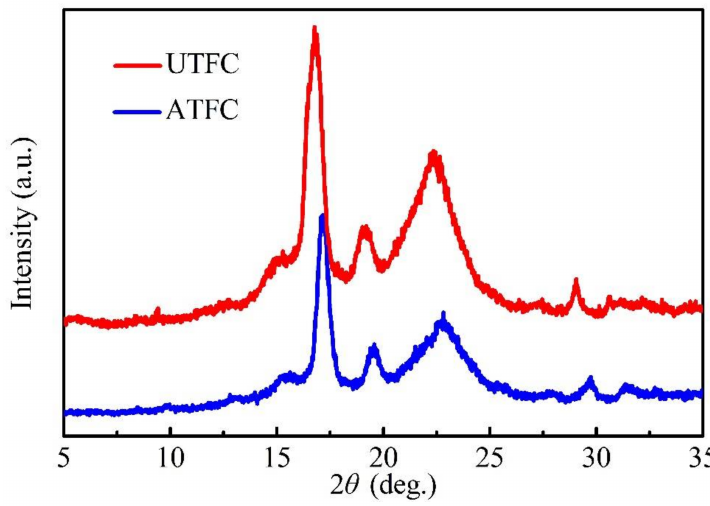
Figure 8. XRD patterns of PLA-based composites reinforced with untreated and treated